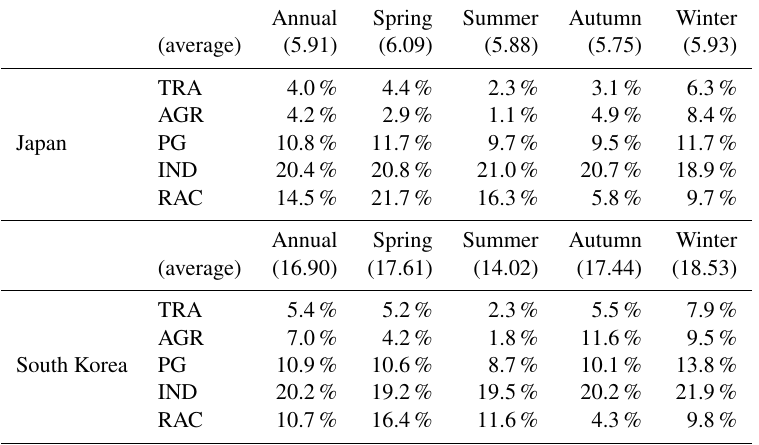
Table 6. Annual and seasonal contributions of Chinese sectoral emissions to surface PM 2 . 5 (µgm − 3 ) in Japan and South Korea. Emission sectors include agriculture (AGR), power generation (PG), ground transportation (TRA), industrial (IND), and residential and commercial (RAC). Agriculture refers to agriculture and agricultural waste burning; power generation refers to electricity generation; ground trans- portation refers to road transportation, rail, pipelines, and inland waterways; industrial refers to energy production other than electricity generation, industrial processes, solvent production and application, and residential and commercial refers to heating, cooling, equipment, and waste disposal or incineration related to